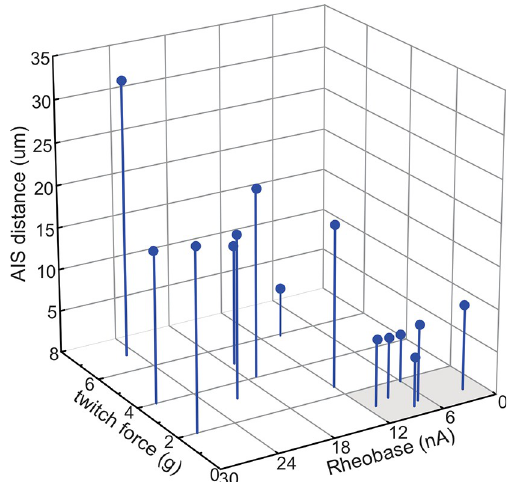
Fig 4. AIS geometry relationship to markers of motor unit recruitment order. 3D plot shows motoneurons with relatively lower rheobase and twitch force (grey highlight), which are typically recruited early during muscle contraction also exhibited the shortest AIS d